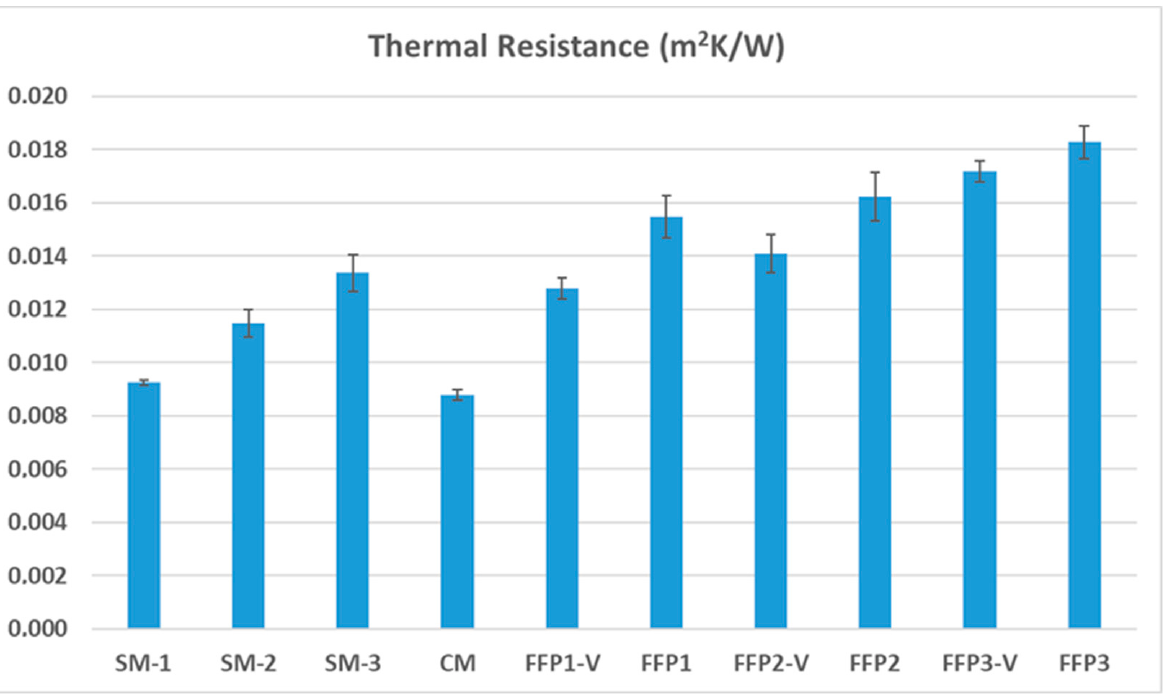
Figure 5. Thermal resistance results of the masks used in the study. Table 4. The results of SNK post hoc tests of the thermal resistance values. Subset for α = Fabric n